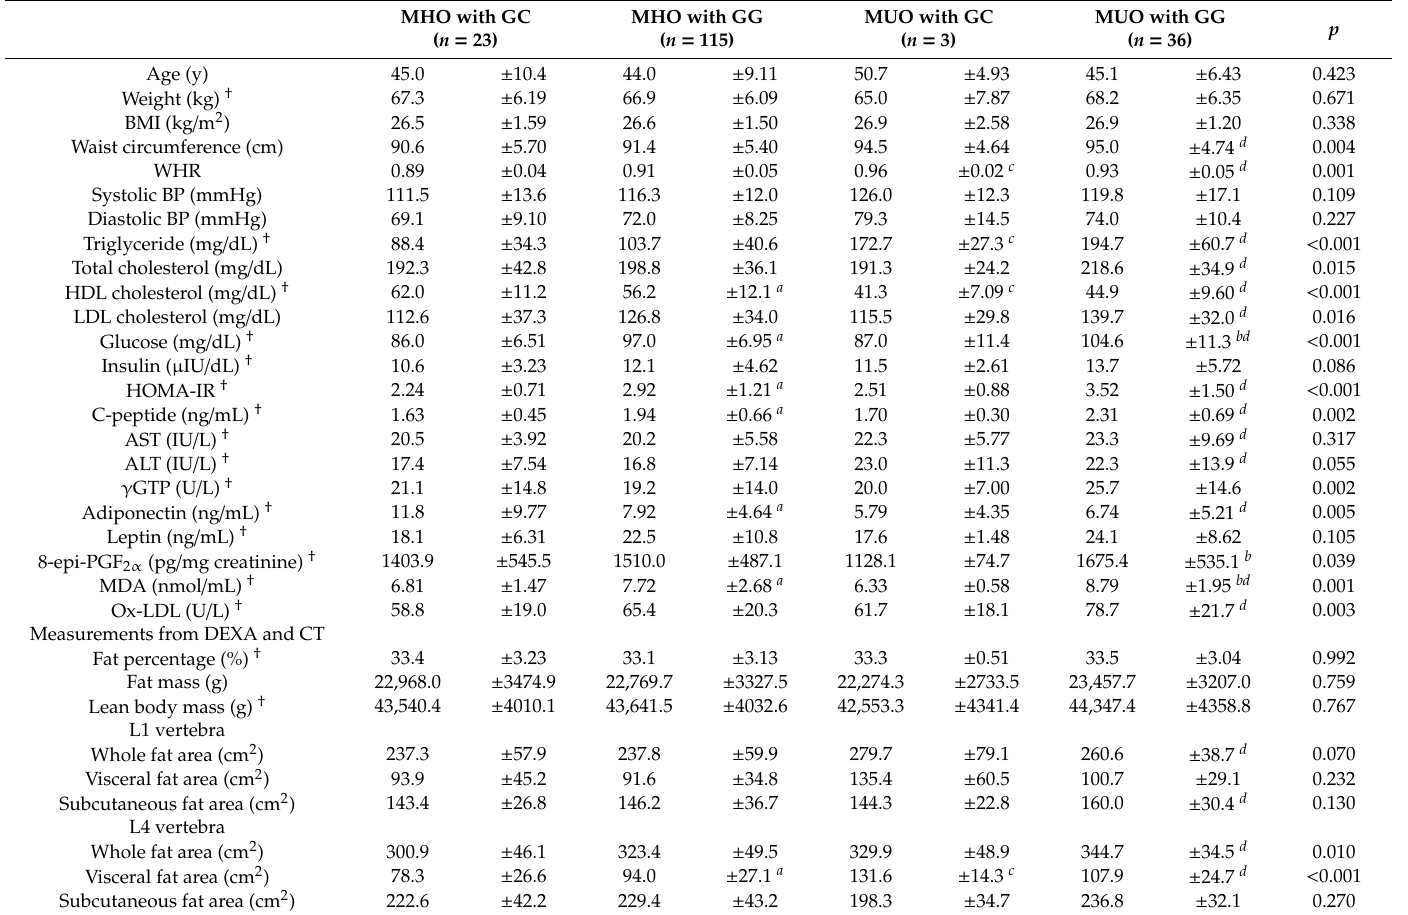
Table 3. Overall di ff erences in biochemical and clinical characteristics among female subjects with obesity according to metabolic status and LEPR rs8179183